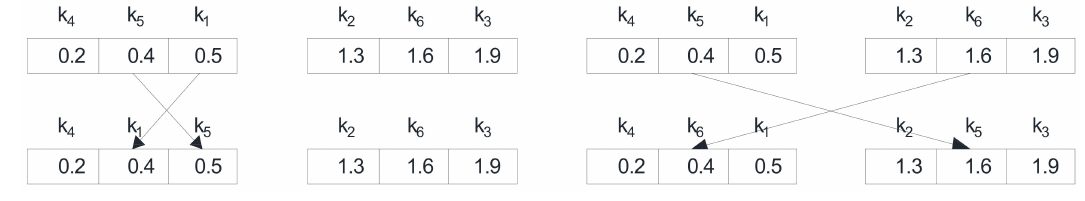
Figure 2. Local search for vessel interchange.